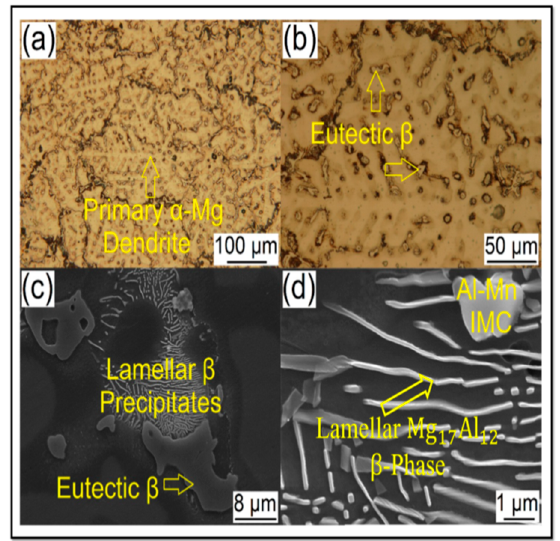
Figure 8. Microstructure of the as-cast AZ91 alloy: ( a , b ) optical microscopy (OM) images, and ( c , d ) scanning electron microscopy (SEM) images (Reprinted with permission from ref. [15]. Copy- right 2020 Elsevier B.V.).